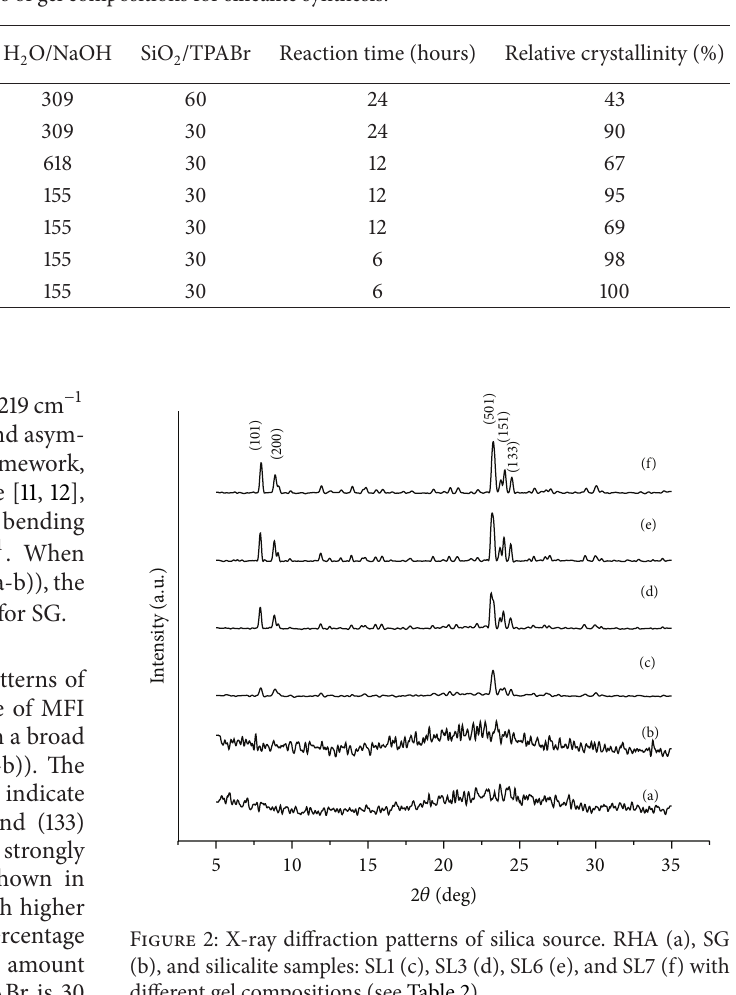
Table 2: Mole ratios of gel compositions for silicalite synthesis.